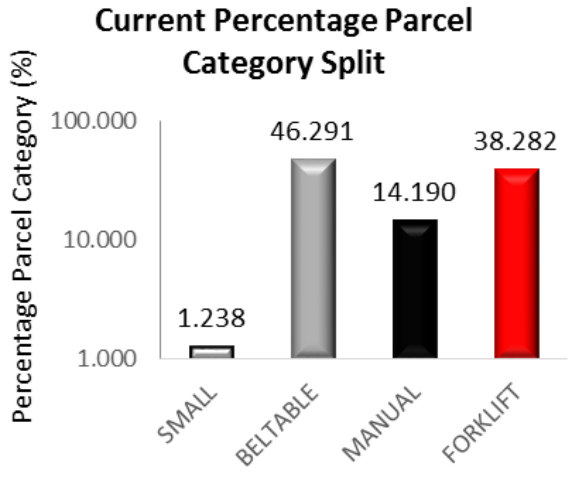
Figure 4: Analysis of the current parcel category percentage